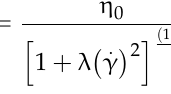
Figure 5. ( a ) Shear stress and ( b ) shear viscosity as a function of shear rate for S1 at various temper- atures.